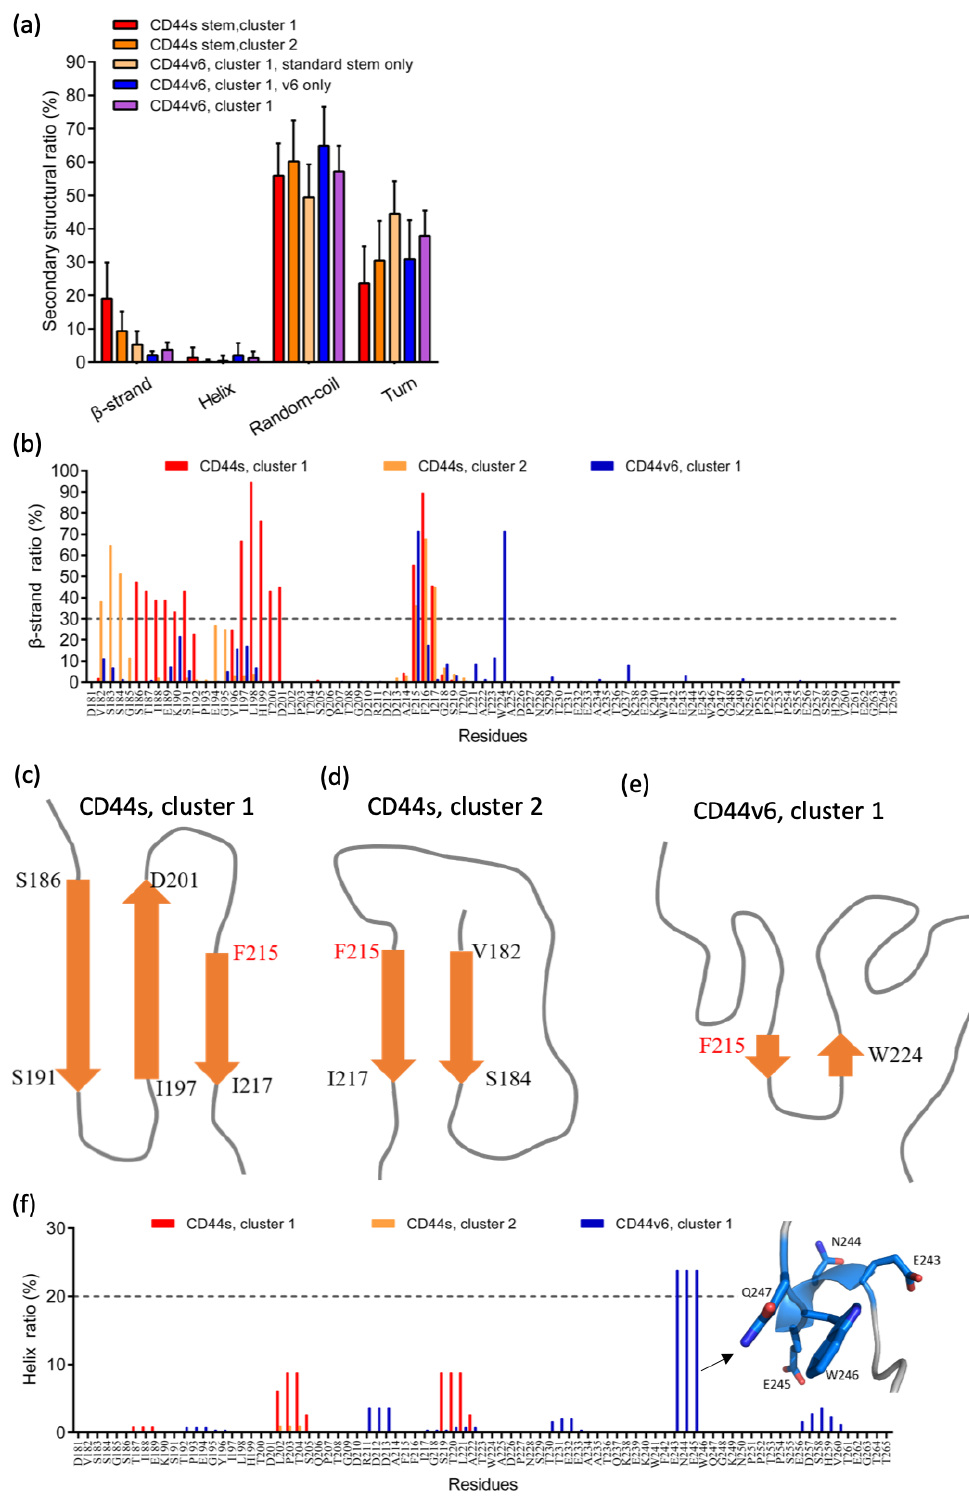
Figure 5. Analysis with secondary structure and regular secondary structure (β-sheet and helix) composition on residue base. ( a ) Average ratio of each secondary structure (including helix, β-sheet, coil, and turn) for all residues and ( b ) β-sheet ratio as a function of amino acid residue. Illustrations of the β-strand arrangements of ( c ) the CD44s stem region, cluster 1; ( d ) the CD44s stem region, cluster 2; and ( e ) the CD44v6 stem region, cluster 1. ( f ) Helix ratio as a function of amino acid residue.